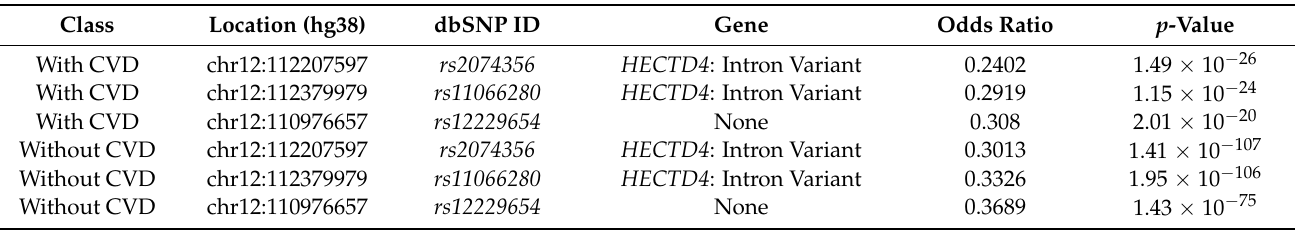
Table 1. The most significant SNPs associated with chronic cardiovascular diseases (CVDs) and without CVD between drinking